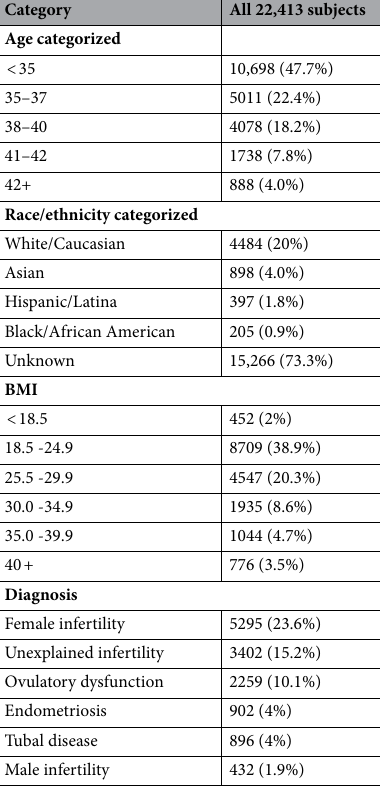
Table 1. Demographic characteristics of patients undergoing in vitro fertilization (IVF) treatment included in our